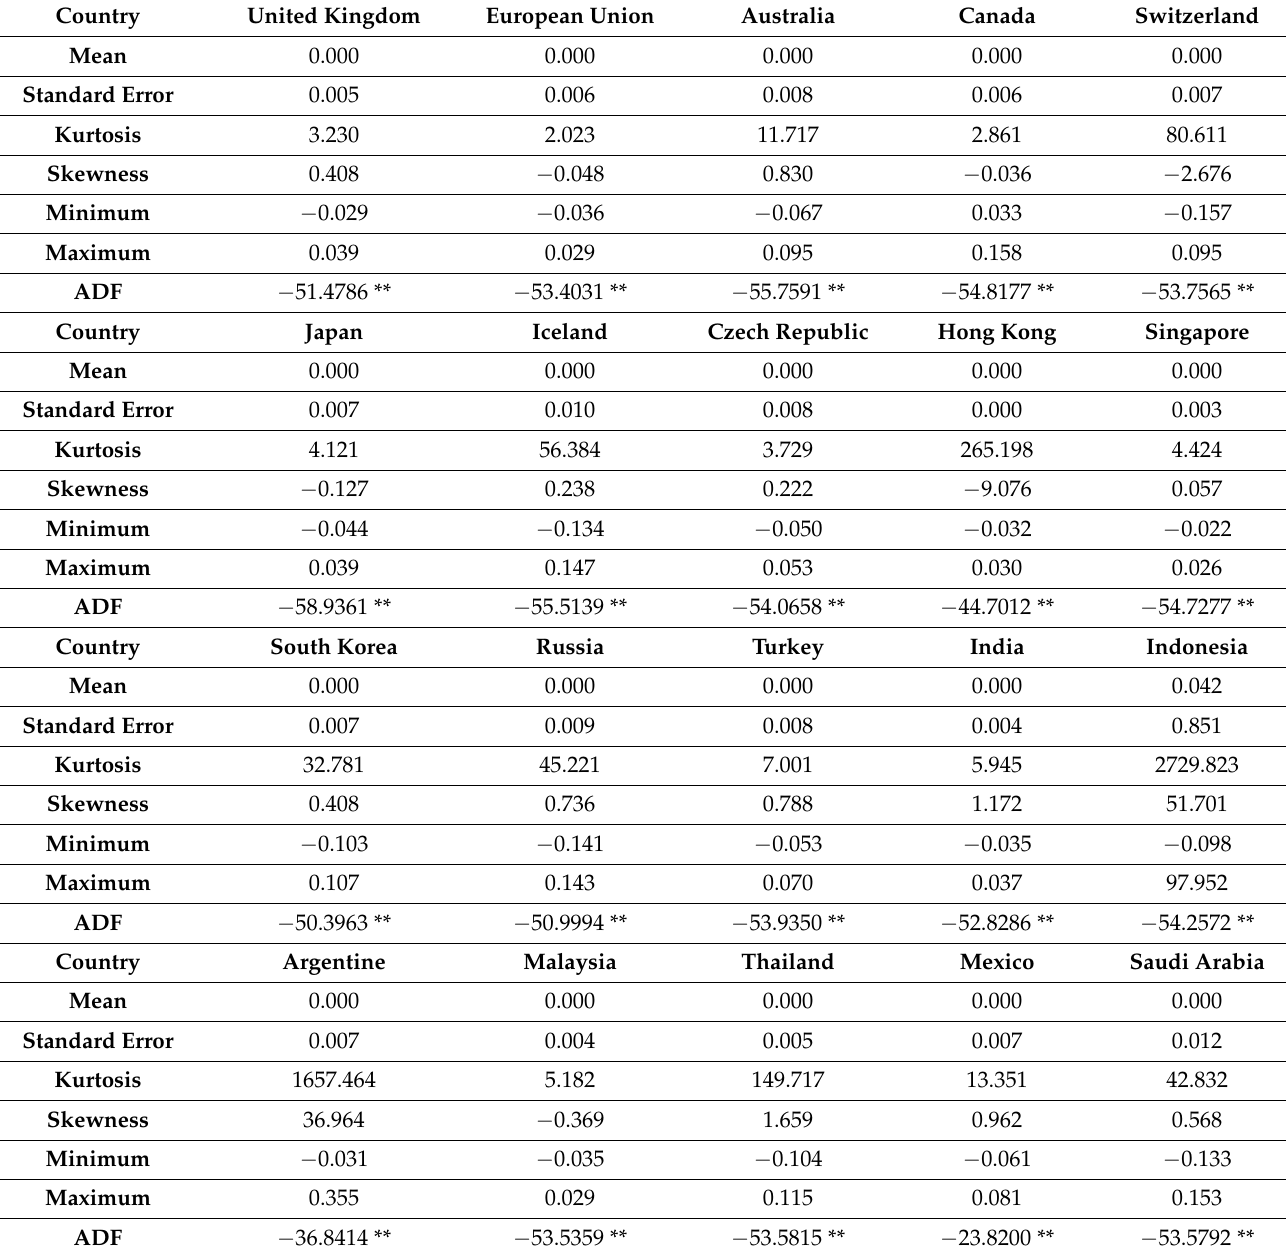
Table 1. Descriptive statistics, global foreign exchange market returns,